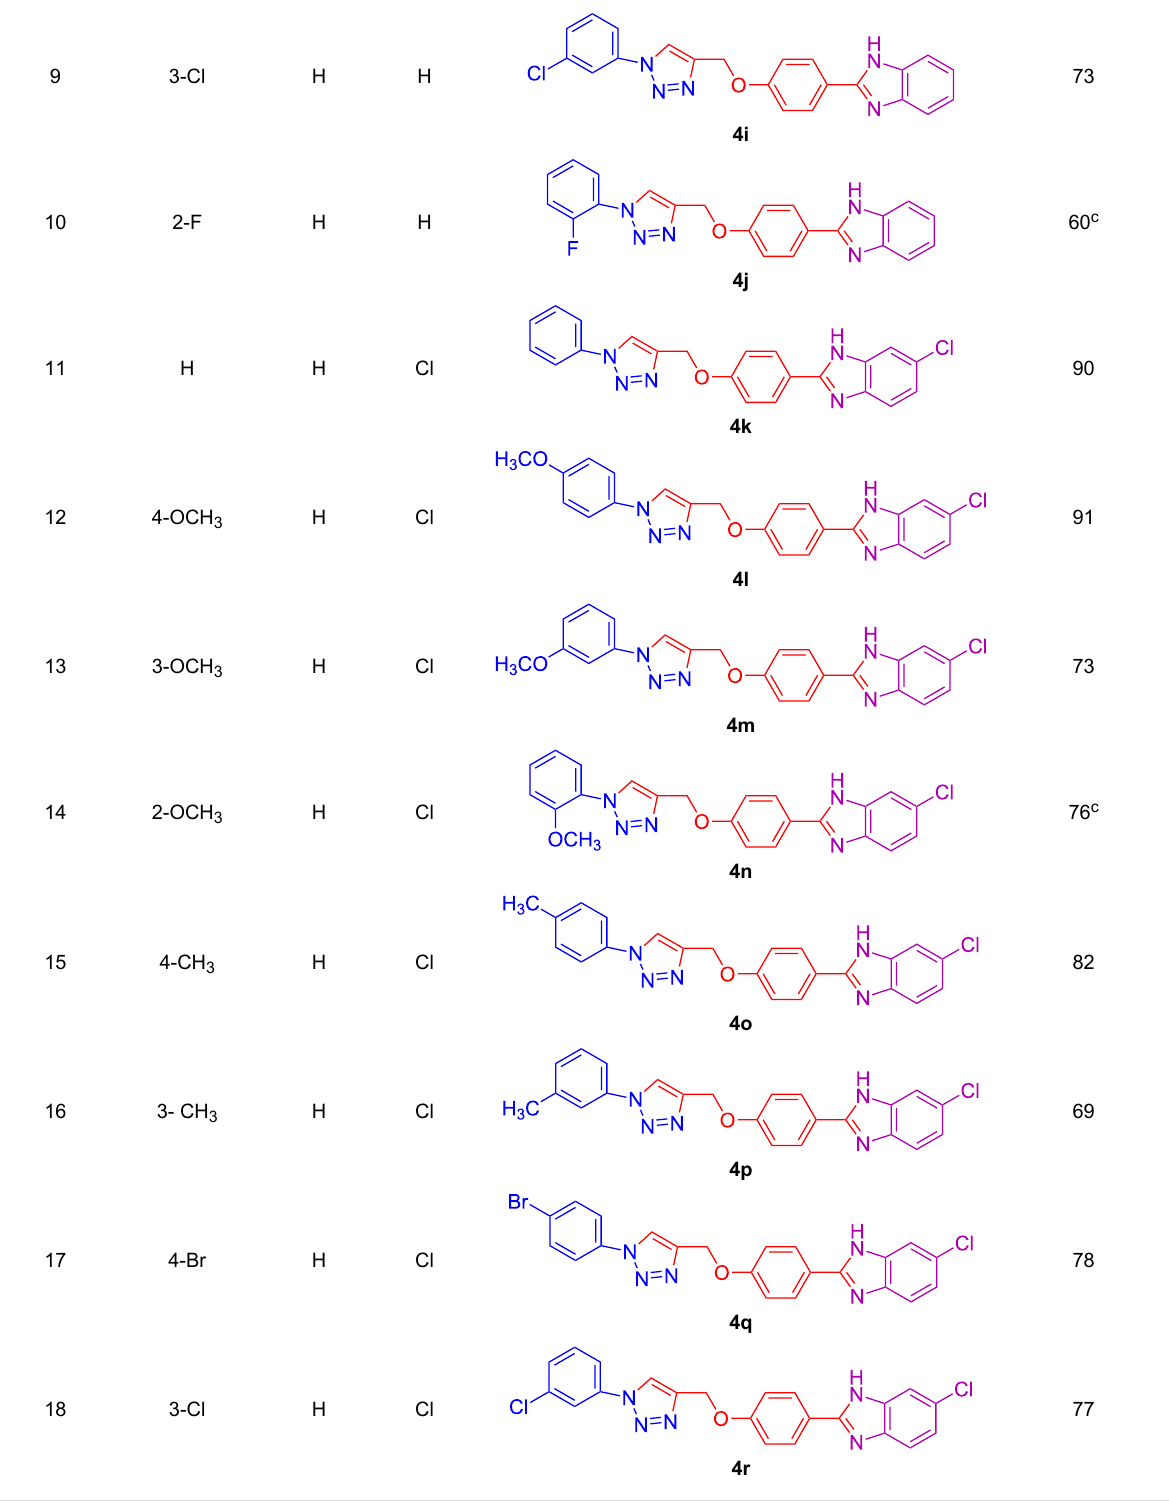
Table 2: Scope and limitations of the protocol employing different 4-(prop-2-yn-1-yloxy)benzaldehydes ( 2 ), phenylazides ( 1 ) and 1,2-diaminoben- zenes ( 3 ) a . (continued)